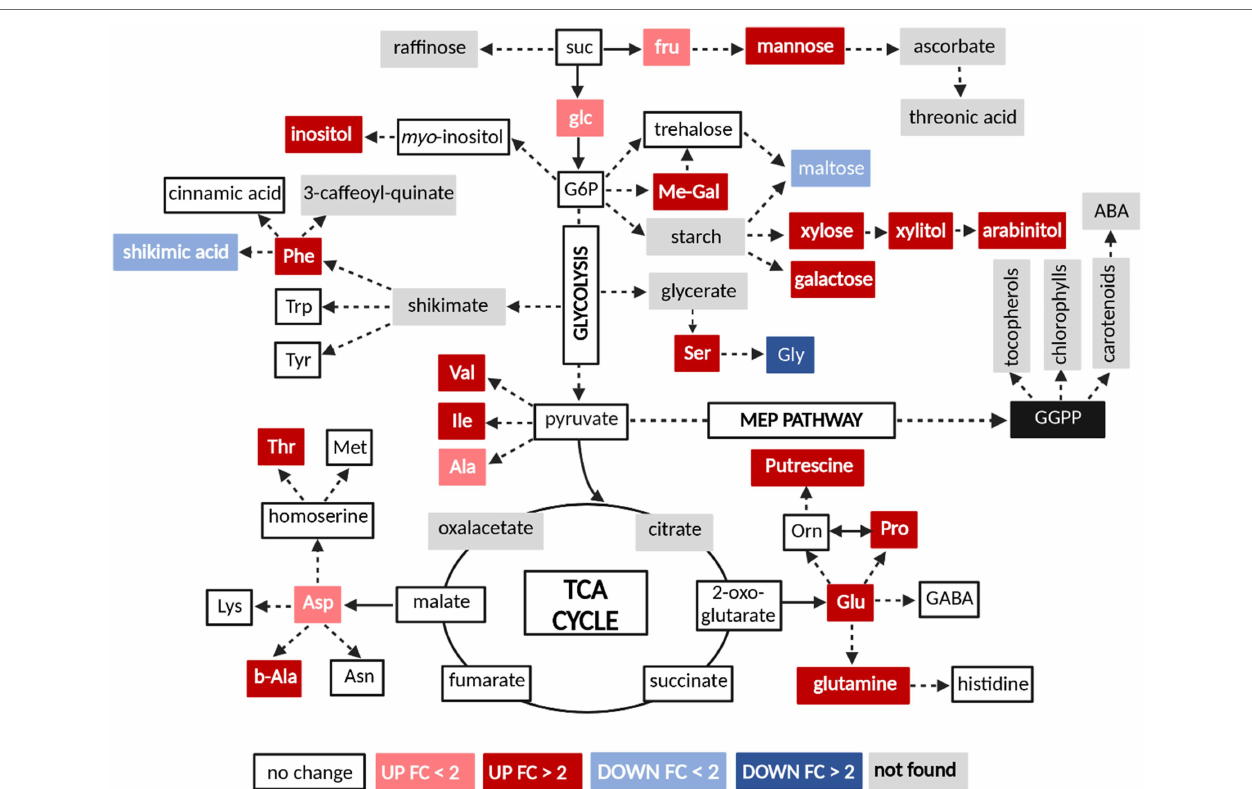
FIGURE 6 | Changes in the levels of selected differentially concentrated metabolites of susceptible cultivar Yunyan87 during R. pseudosolanacearum infection. Colors represent statistically significant fold-change (FC) values ( t test, p < 0.05) of metabolite levels in xylem sap from infected tobacco plants relative to those in healthy plants controls. Suc, sucrose; Glc, glucose; Fru, fructose; Me-Gal, methyl-alpha-D-glucopyranoside; Ser, serine; Gly, glycine; Phe, phenylalanine; Trp, tryptophan; Tyr, tyrosine; Val, valine; Ile, isoleucine; Ala, alanine; Glu, glutamic acid; Orn, ornithine; Pro, proline; Asp, aspartic acid; Thr, threonine; Met, methionine; Lys, lysine; b-Ala, beta-alanine; Asn, asparagine. This figure was created by bio Render (https://biorender.com/).